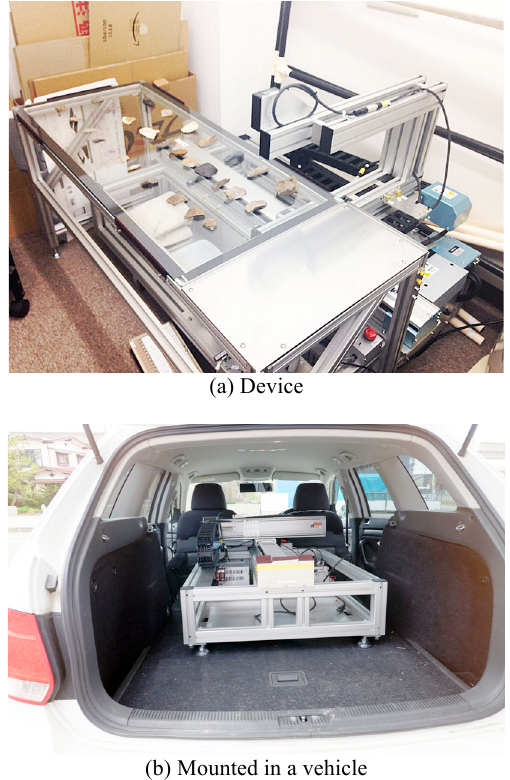
Figure 13. Planar-type 3D measurement device